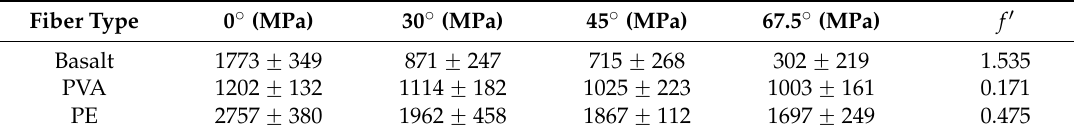
Figure 4. Normalized fiber strength with inclination angle: ( a ) Basalt fiber ( b ) polyvinyl-alcohol (PVA) fiber; and ( c ) polyethylene (PE) fiber. Table 6. Average fiber tensile strength and strength reduction coefficient.